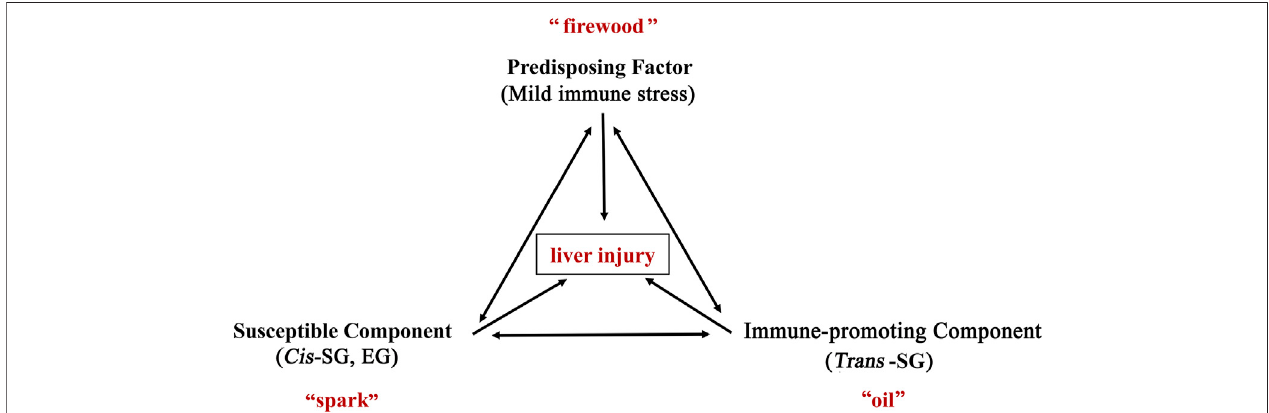
FIGURE 5 | The immunological stress-mediated tri-element injury hypothesis of idiosyncratic toxicity of PM. During an abnormally activated state (mild immune stress) ofthe body ’ s immune system, the immune-promoting components in PM ( trans -SG) may enhance the body ’ s immune activation, and at the same time increase the susceptibility of the liver to certain components ( cis -SG, EG), resulting in the overexpression of in fl ammatory cytokines, leading to liver injury. It is also called the " fi rewood-oil-spark hypothesis", in which the abnormally activated immune system is equivalent to " fi rewood", the immune-promoting components in PM are equivalentto"oil",andthepotentiallysusceptible componentsforliverinjuryisequivalentto"spark".Asingleriskfactormaynotcatch fi re,butwhenthreeriskfactorsare presentatthesametime,asmallsparkmaycausearaging fi re(acuteliverinjury).Abbreviations: trans -SG, trans -2,3,5,4 ’ -tetrahydroxystilbene-2-O- β -glucoside; cis -SG, cis - 2,3,5,4 ’ -tetrahydroxystilbene-2-O- β -glucoside; EG, emodin-8-O-glucoside; PM, Reynoutria multi fl ora (Thunb.)